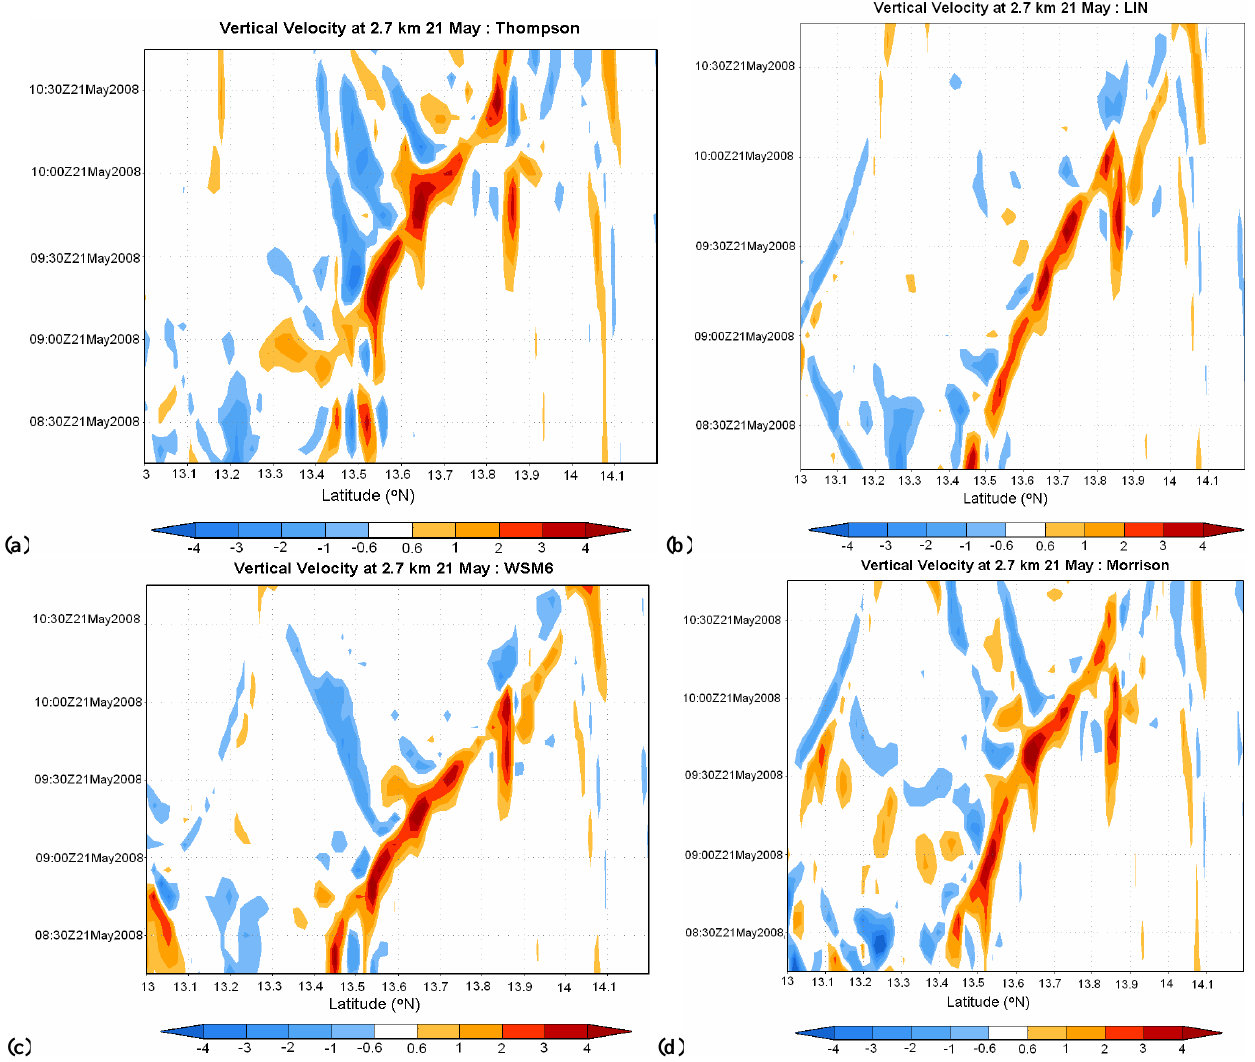
Fig. 7. Latitude-Time plot showing northward propagation of vertical velocity (ms − 1 ) at 2.7km simulated by the model with four different MP schemes. (a) Thompson, (b) Lin, (c) WSM6, and (d)